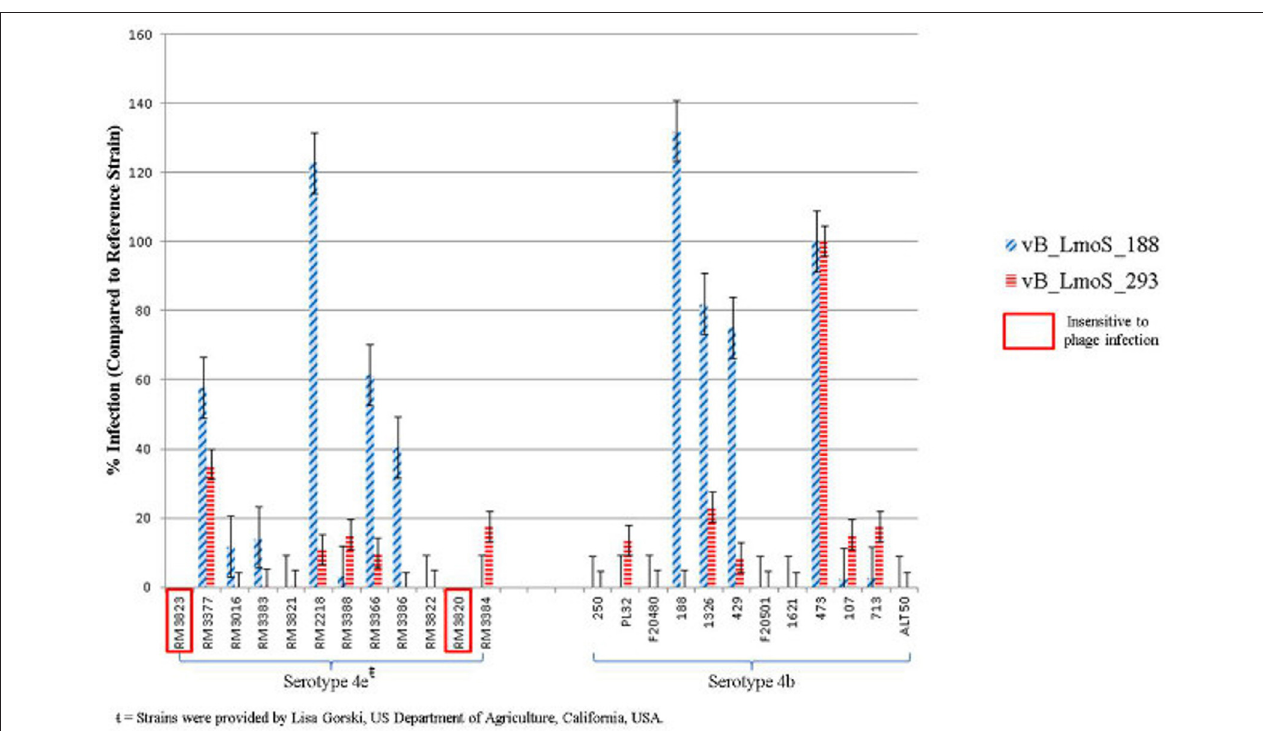
FIGURE 1 | Percentage infection levels of each of phages vB_LmoS_188 and vB_LmoS_293 against a selection of serotype 4b and 4e strains of L. monocytogenes . The percentages recorded are the average of duplicate assays, and have been normalized using strain 473 as a reference. The error bars for each value represent the standard error of the mean. Strains highlighted demonstrated no sensitivity to phage infection from either of the phages tested.